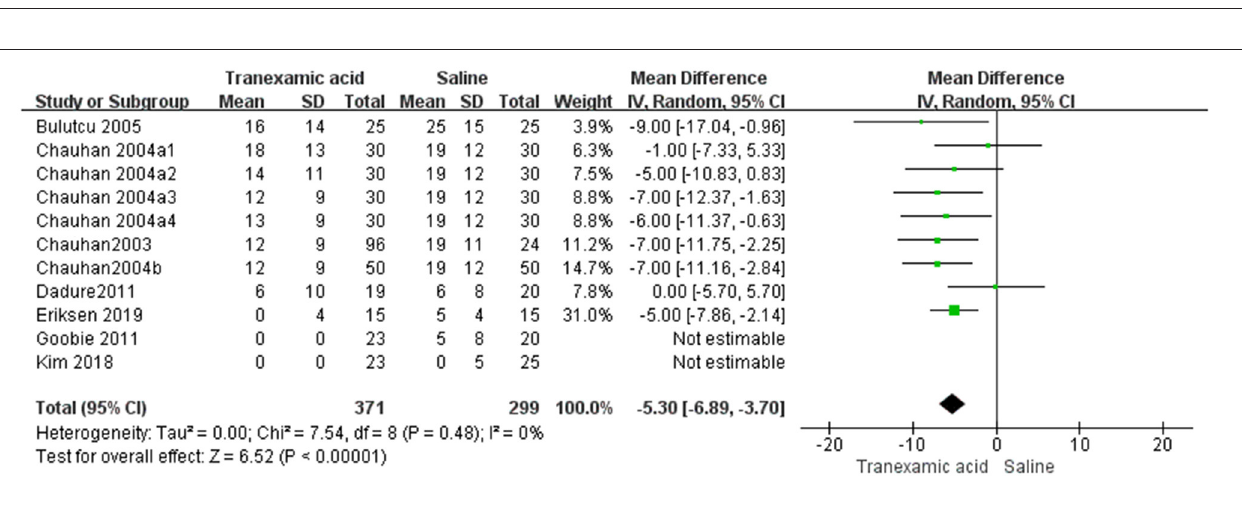
FIGURE 5 | Meta-analysis of intraoperative RBC transfusion for TXA compared with placebo.